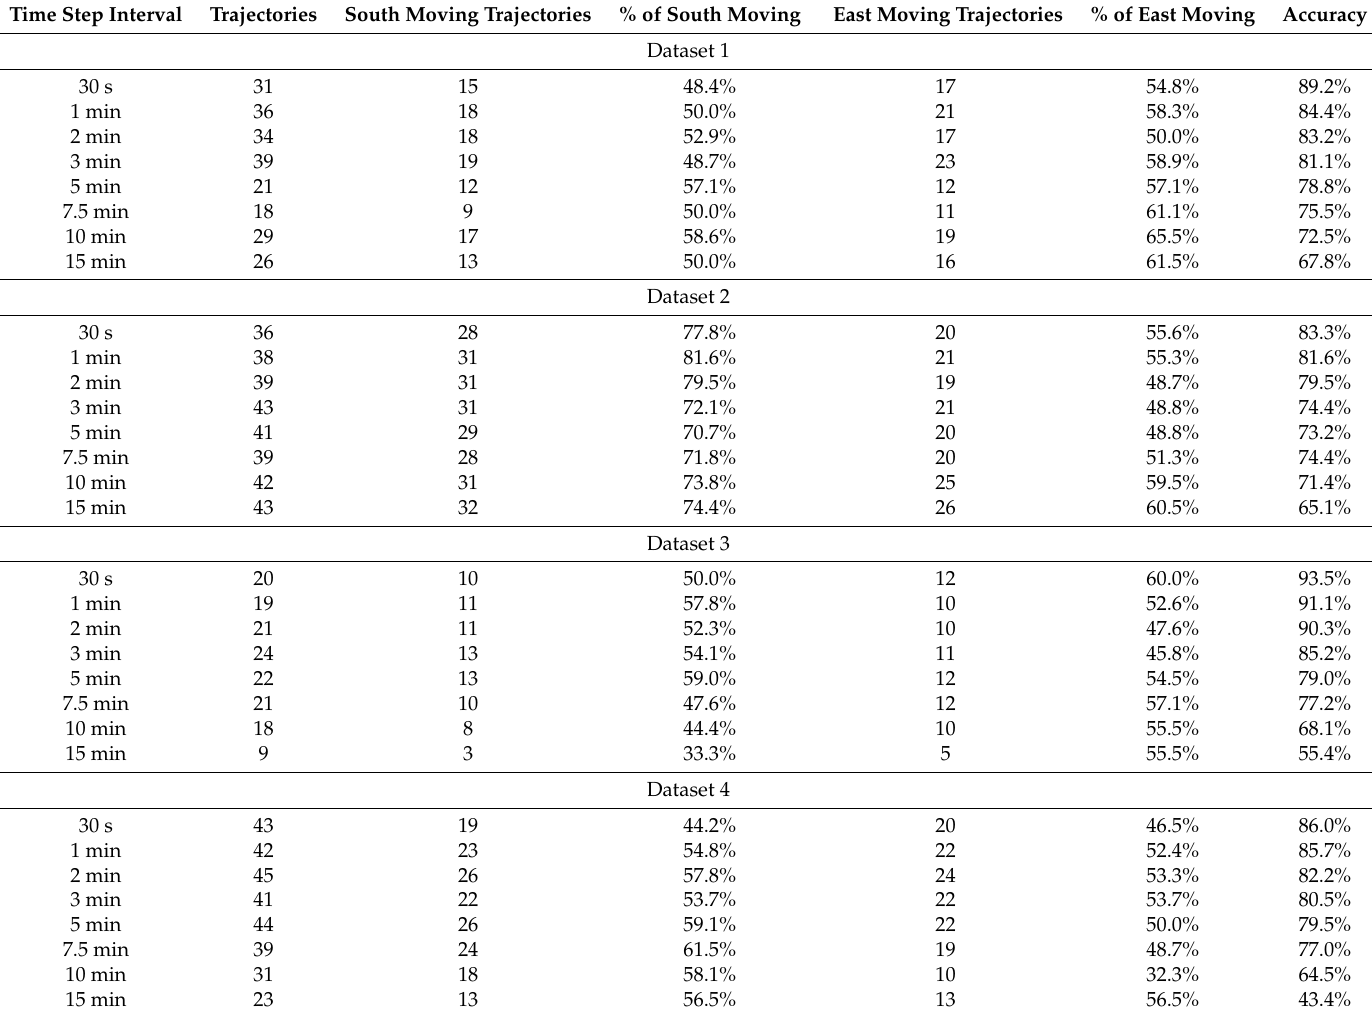
Table 2. Summary of our tracking results from two selected datasets using the second